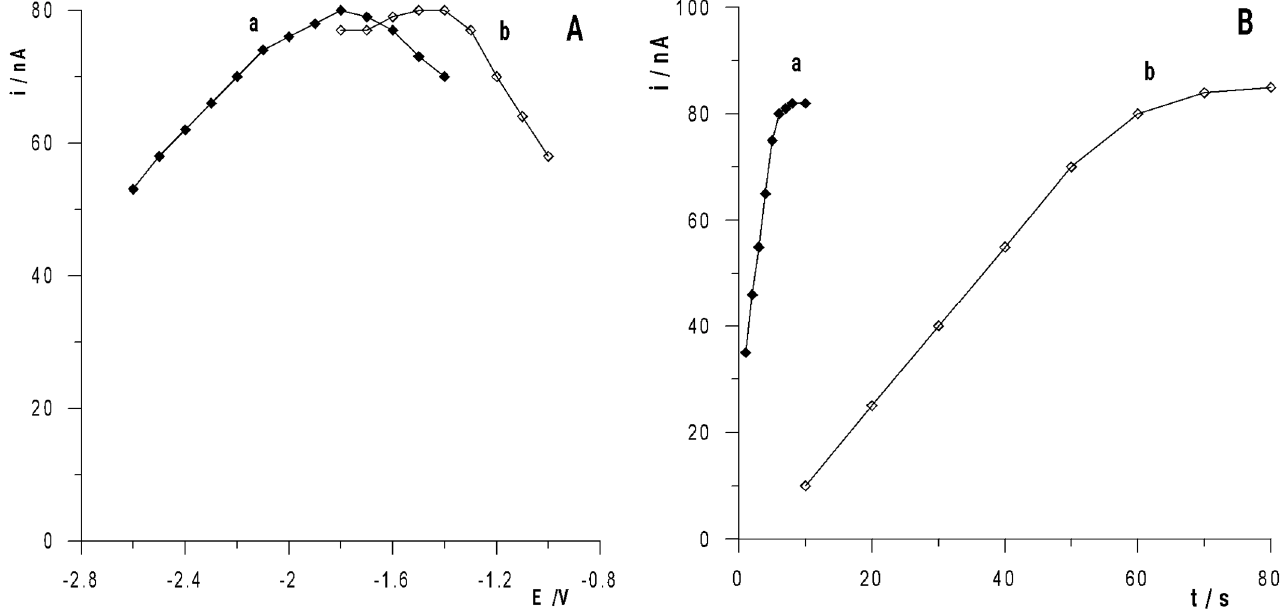
Figure 2. ( A ) The influence of activation potential on 2 × 10 − 7 mol L − 1 Ga(III) peak current: (a) first activation potential was changed for 6 s, second activation potential was constant − 1.4 V for 60 s; (b) first activation potential was constant − 1.8 V for 6 s, second activation potential was changed for 60 s. ( B ) The influence of activation time on 2 × 10 − 7 mol L − 1 Ga(III) peak current: (a) first activation time was changed at − 1.8 V, second activation time was constant 60 s at − 1.4 V; (b) first activation time was constant 6 s at − 1.8 V, second activation time was changed at − 1.4 V.